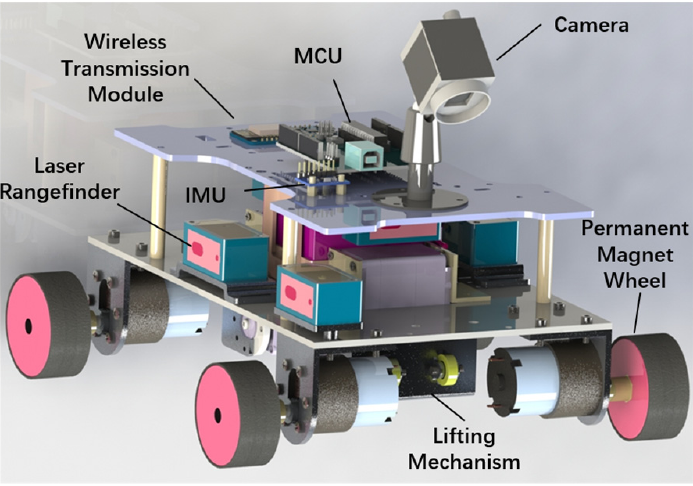
Figure 3. The internal structure of the wall-climbing robot.